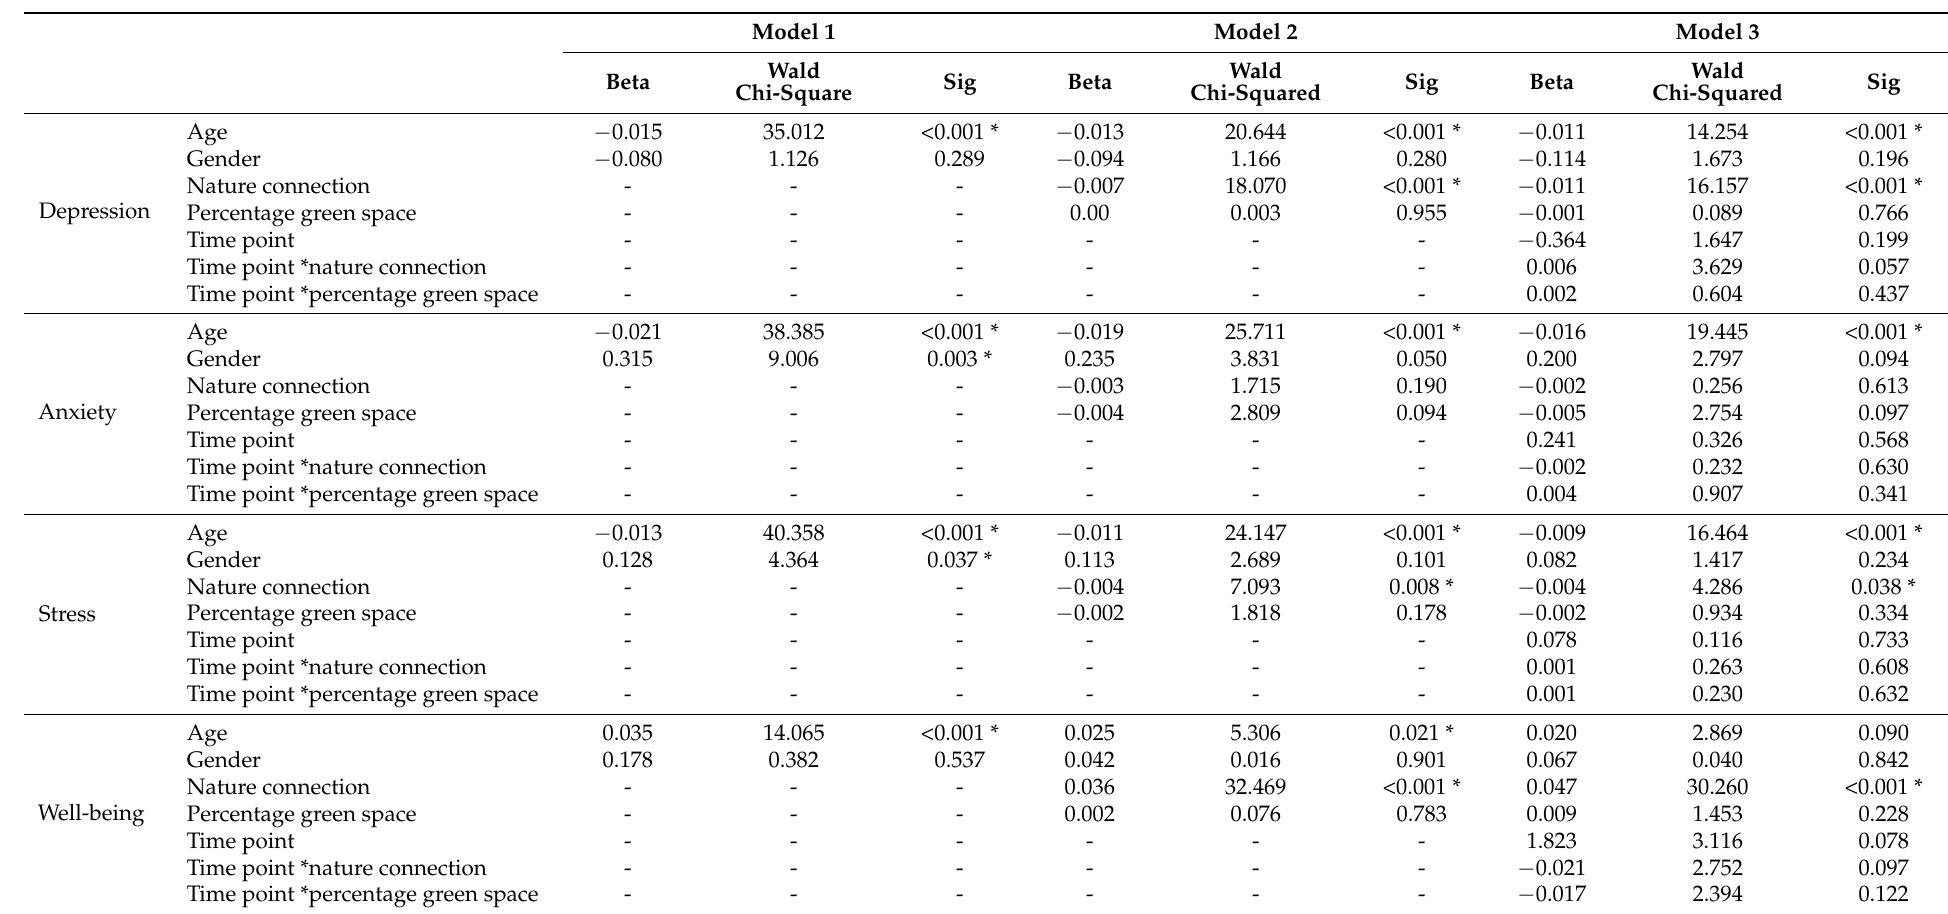
Table 4. Parameter estimates for model